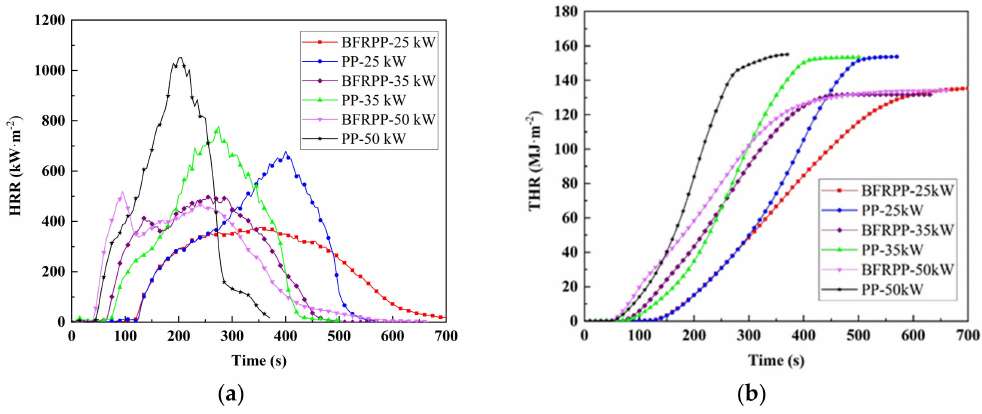
Figure 14. Heat release rate (HRR) and total heat release (THR) curves: ( a ) HRR and ( b )